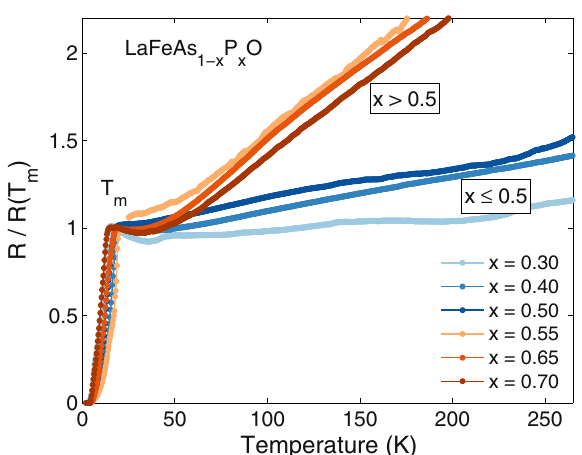
Fig. 1 Split resistivity curves. Normalized resistivity vs. temperature for the LaFeAs 1 − x P x O series synthesized under high-pressure conditions. All samples become superconducting after reaching a local maximum at T m . Notice the different behavior of samples with x ≤ 0.5 from those with x > 0.5, highlighted by two different color